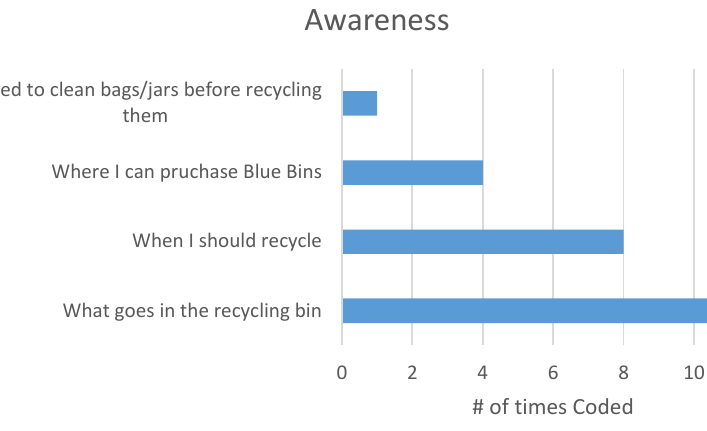
Figure 8. Coded Responses to Newspaper Advertisements (Awareness).